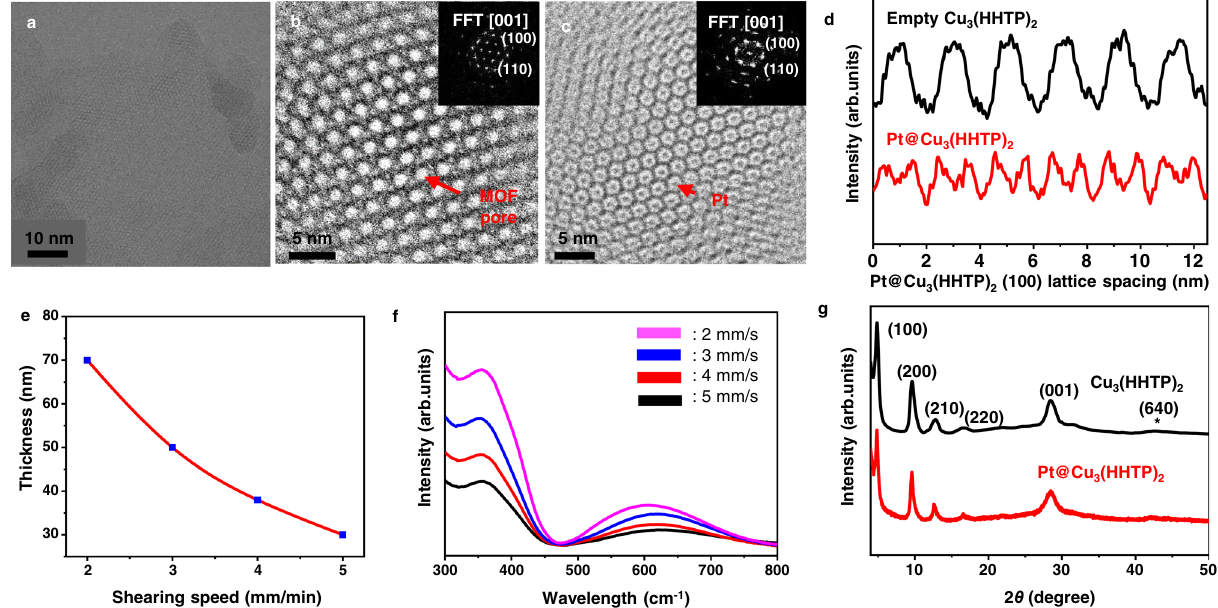
Fig. 3 Characterization of Pt@C-MOF thin fi lms fabricated by MiCS. a Cryo-TEM image of Pt@Cu 3 (HHTP) 2 under low magni fi cation. b High-resolution Cryo-TEM image of Pt@Cu 3 (HHTP) 2 without Pt particles in the MOF pores. c High-resolution Cryo-TEM image of Pt particles immobilized in the MOF pores. d Integrated intensity of Pt@Cu 3 (HHTP) 2 plotted over six unit cells along the [100] direction, indicating a pattern when Pt particle is introduced into the pores. e Thickness control of Pt@Cu 3 (HHTP) 2 thin fi lm via controlling the shearing speeds. f UV – Vis spectrum of different thicknesses of Pt@Cu 3 (HHTP) 2 thin fi lm. g PXRD data of Cu 3 (HHTP) 2 and Pt@Cu 3 (HHTP) 2 . @ means –